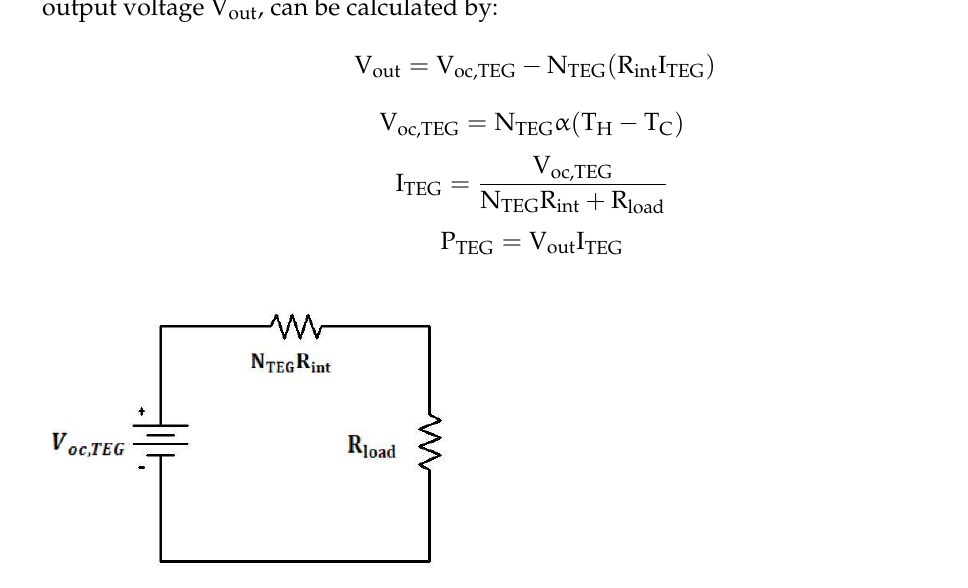
Figure 3. Thermoelectric generator module.